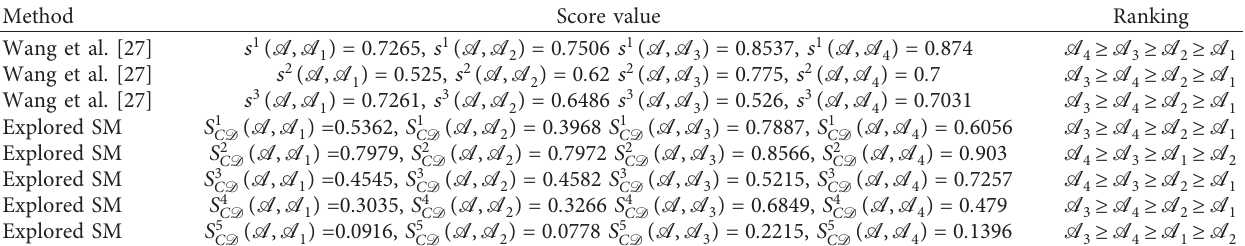
Table 5: Comparison between explored and existing SMs for Example 5 when λ � 1 and ( η Method Score value Ranking Wang et al. [27]